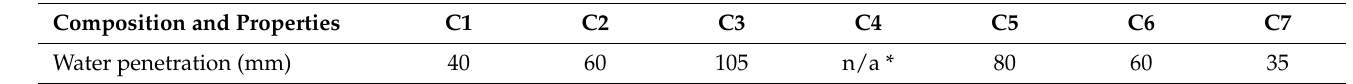
Table 4. Water penetration resistance of the